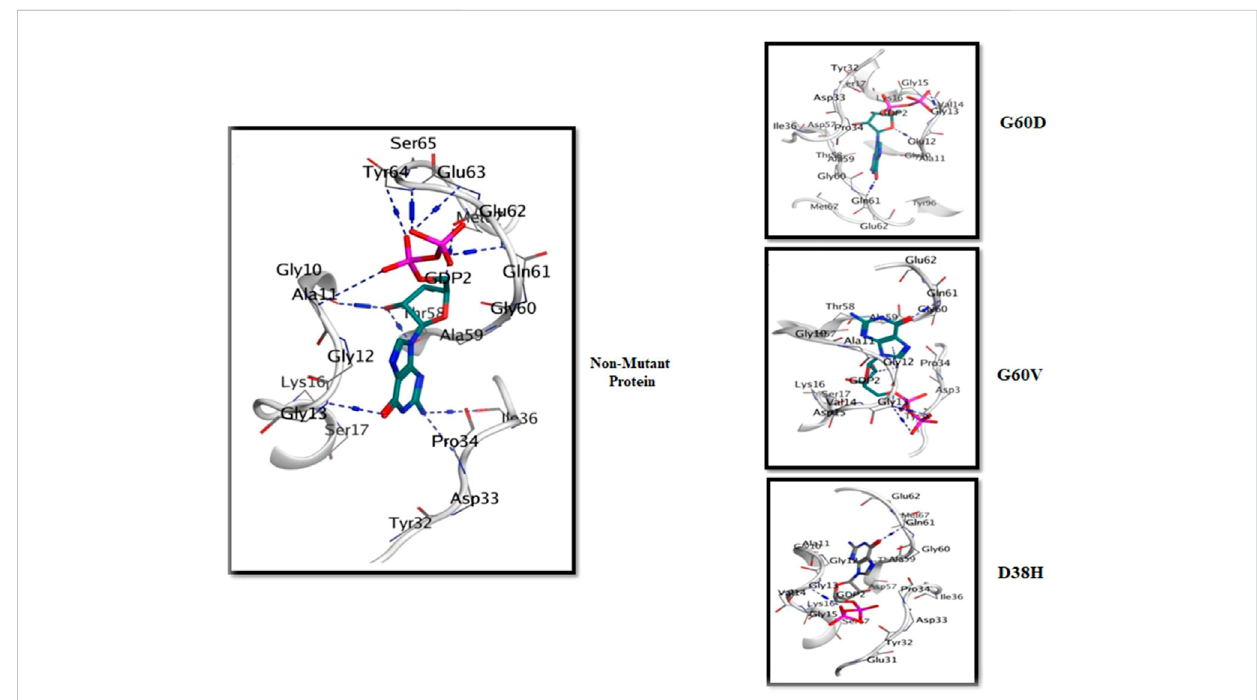
FIGURE 6 The 3D interaction of the docked complexes (G60V, G60D and D38H with Non-mutant protein).